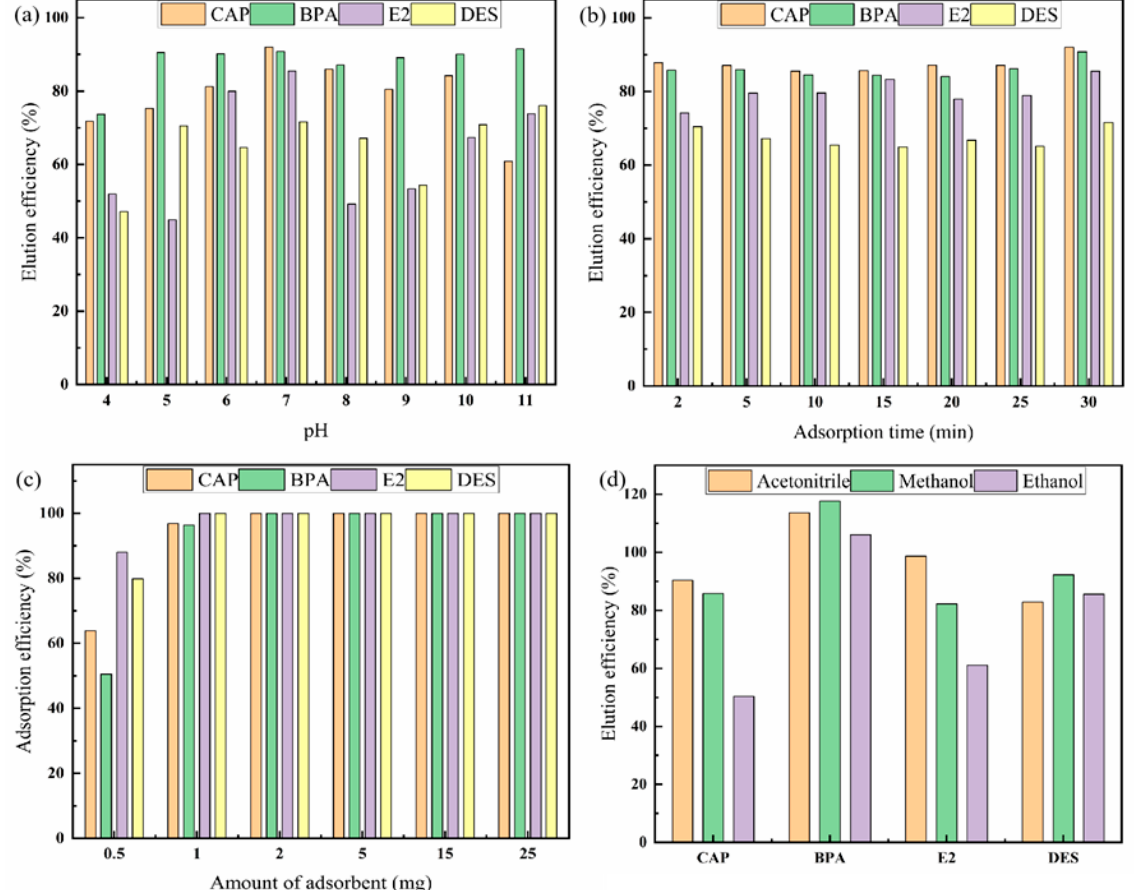
Figure 3. Effect of sample pH ( a ), adsorption time ( b ), the amount of adsorbent ( c ) and elution solvent ( d ) on the recoveries of CAP, BPA, E2, and DES.